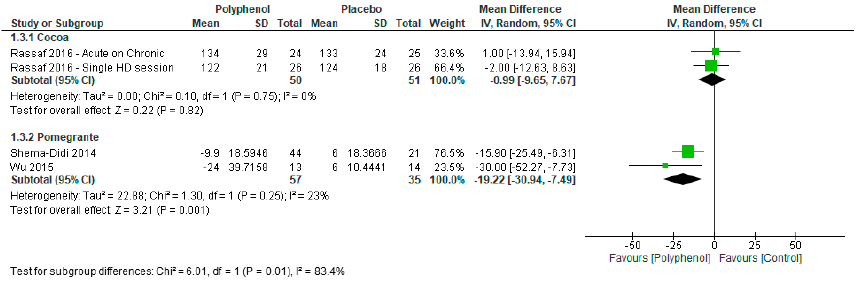
Figure 4. Sensitivity analysis of polyphenol-rich interventions on systolic blood pressure.